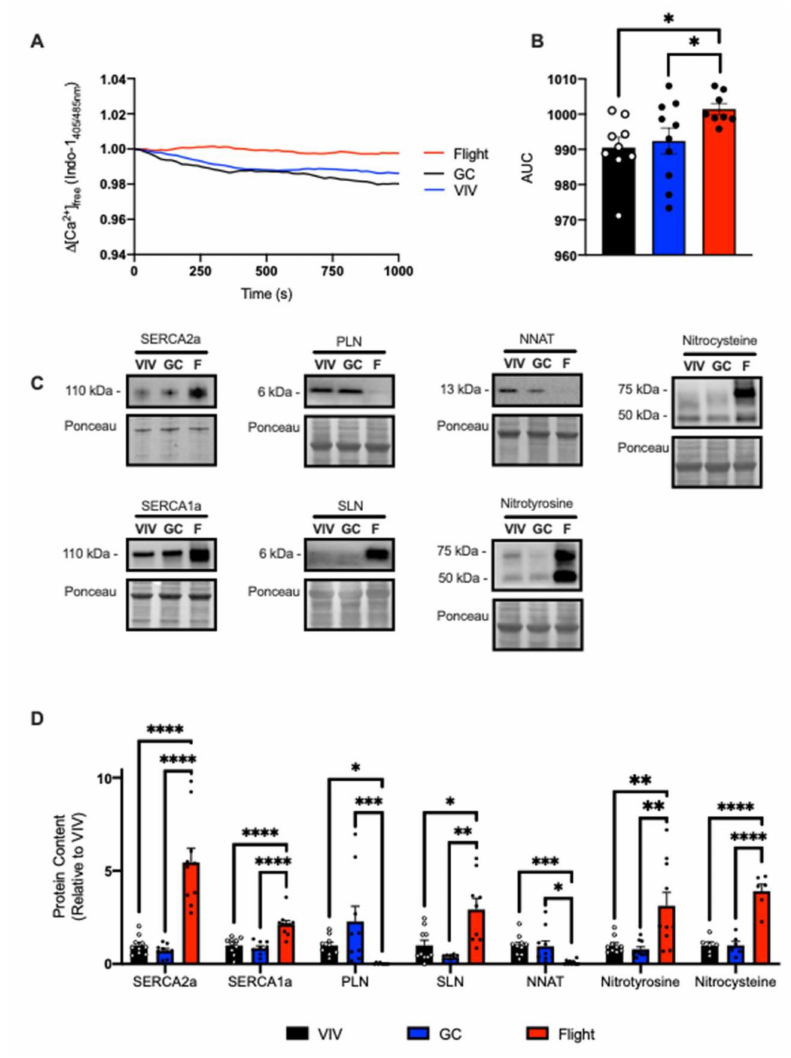
Figure 1. Spaceflight reduced Ca 2+ uptake in the soleus from male mice. ( A ) Change in the ra- tio of Ca 2+ -bound to Ca 2+ -free Indo-1 (405/485 nm emission). ( B ) Area under the curve (AUC) measurements show significant increases in the flight group, representing impaired Ca 2+ uptake. Representative Western blot images ( C ) and densitometric analysis ( D ) of SERCA2a/1a, PLN, SLN, NNAT, and total protein T-nitration and S-nitrosylation. All values are means ± SEM, and Western blot data are presented relative to VIV control. * p < 0.05; ** p < 0.01; *** p < 0.005; **** p < 0.0001